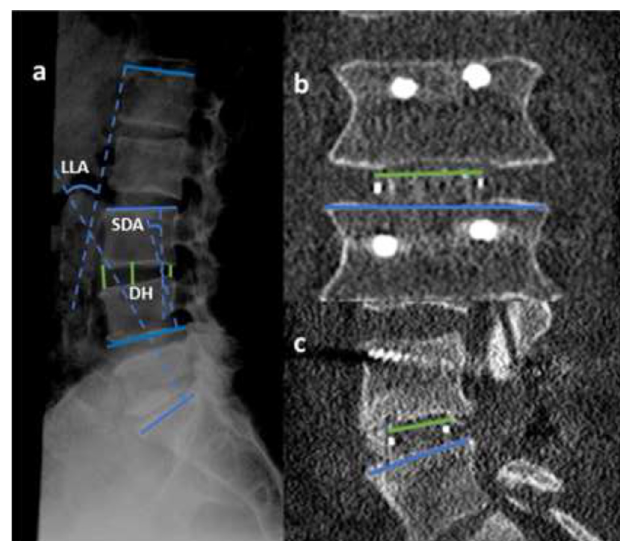
Figure 2. (a) Measurement of LLA, SDA and A,M,P/DH using lateral plain X-ray in a neutral position, (b,c) % CC along transverse and anteroposterior